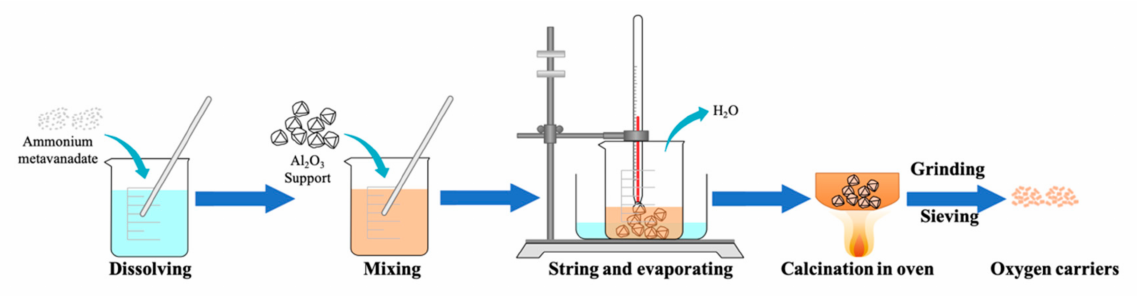
Figure 11. The preparation procedure of impregnation